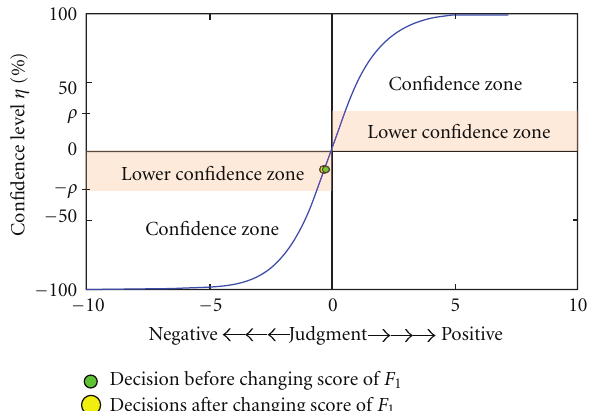
Figure 8: Fact finding of evaluator E 1 by varying the evaluation of factor F 1 over the interval [ − 10,10]. Before changing the score of the factor F 1 , the confidence of the decision of evaluator E 1 is − 14%. After changing the score of the factor F 1 , the confidence level of the decision of evaluator E 1 varies only over a small range of [ − 13 . 96%, − 13 .